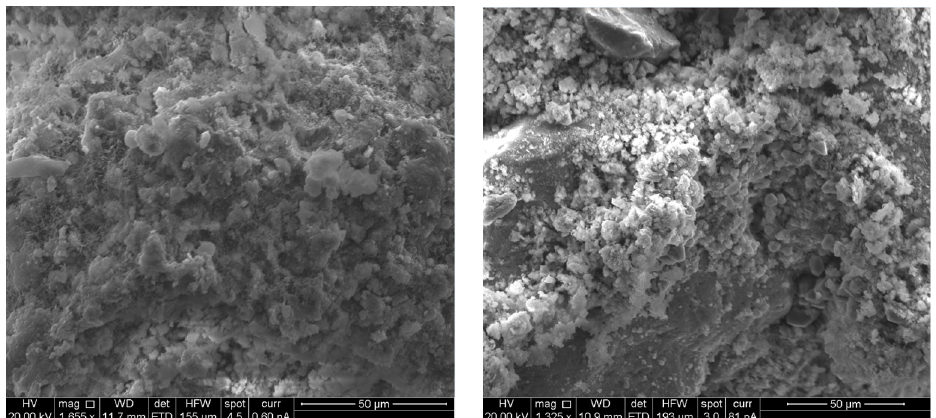
Figure 13. Cement plain mortar ( left ); cem+bio mortar ( right ).